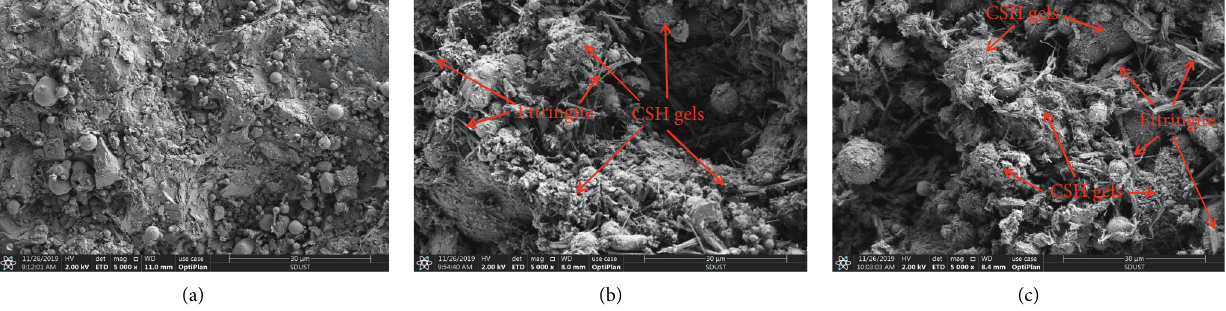
Figure 11: SEM images of CPB samples cured at 60 ° C for 12 hours: (a) RM, (b) PC, and (c) SC.